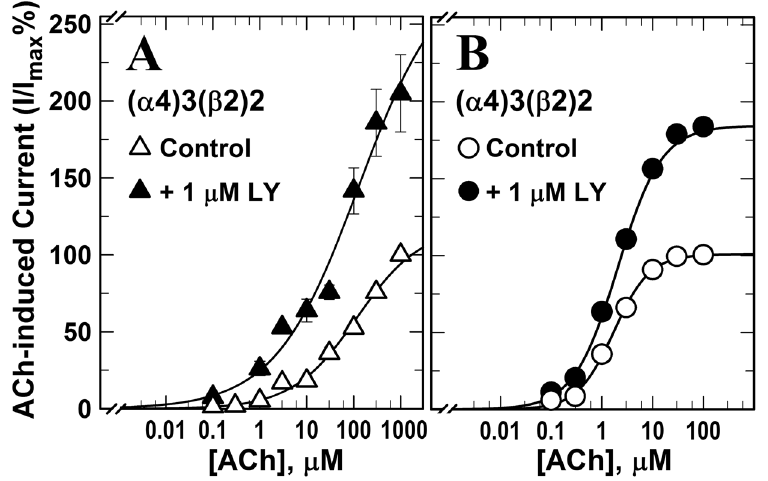
Figure 3. Effect of LY2087101 on the ACh dose-response curves of low- and high-sensitivity α 4 β 2 nAChRs. ACh current responses of Xenopus oocytes expressing human ( α 4)3( β 2)2 ( A , △ , ▲ ) or ( α 4)2( β 2)3 ( B , ● , ○ ) nAChRs were recorded in the absence of any other drug ( △ , ○ ) and in the presence of 1 µ M LY2087101 ( ▲ , ● ). For each ACh concentration ( − / + LY2087101), peak current response was normalized to the peak current response elicited by 1 mM ACh in the same recording run. Replicas from individual oocytes were averaged and Averages ± SE for N oocytes ( A , 18 ( △ ), 8 ( ▲ ); B , 12 ( ○ ), 13 ( ● )) were plotted and fit to Equation 1. Values of ACh EC 50 / h / I max were: for ( α 4)3( β 2)2 nAChR ( A ), ACh (control), 113 ± 26 μ M/0.66 ± 0.06/117 ± 6%; ACh( + 1 LY2087101), 71 ± 25 μ M/0.7 ± 0.1/251 ± 19%; for ( α 4)2( β 2)3 nAChR ( B ), ACh (control),